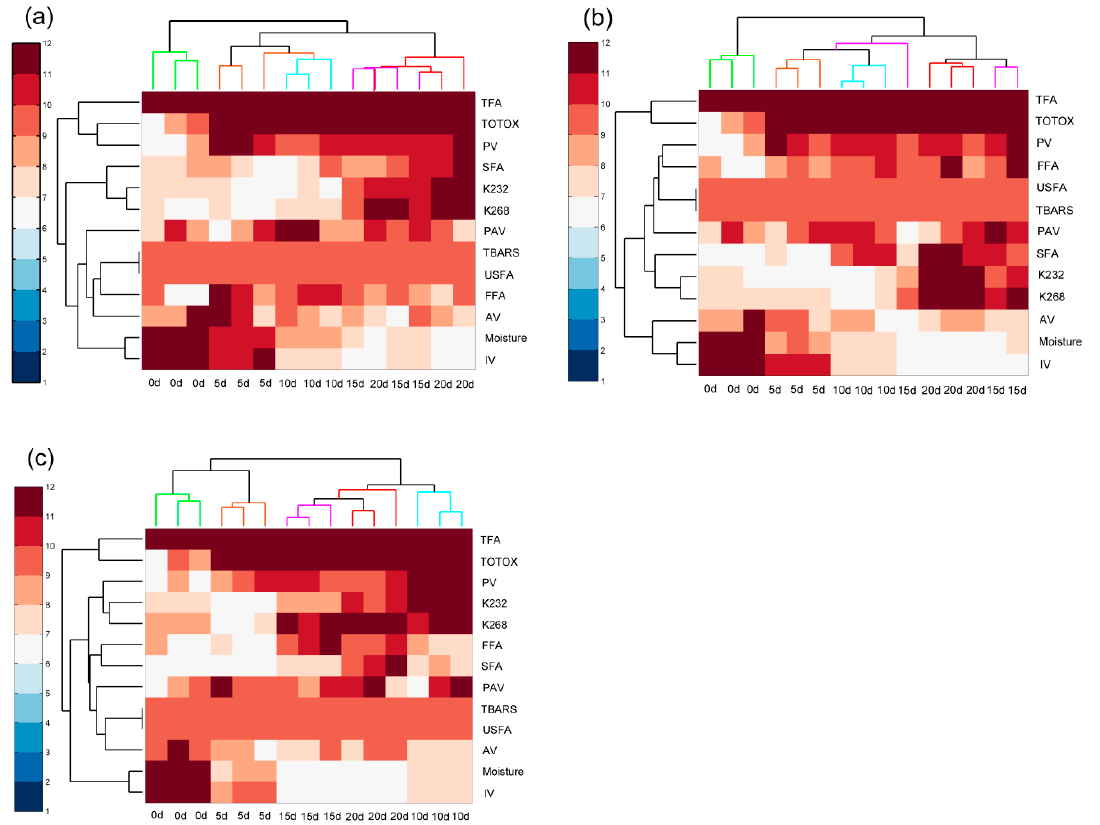
Figure 4. HCA of green coffee beans during accelerated storage based on the fused dataset ( a : 40 °C; b : 50 °C; c : 60 °C). TFA, trans fatty acid; TOTOX, total oxidation value; PV, peroxide value; K232, the absorbance at 232 nm; K268, the absorbance at 268 nm; FFA, free fatty acids; SFA, saturated fatty acids; PAV, p -anisidine value; TBARS, thiobarbituric acid reactive substances; USFA, unsaturated fatty acids; AV, acid value; Moisture, moisture content; IV, iodine value.